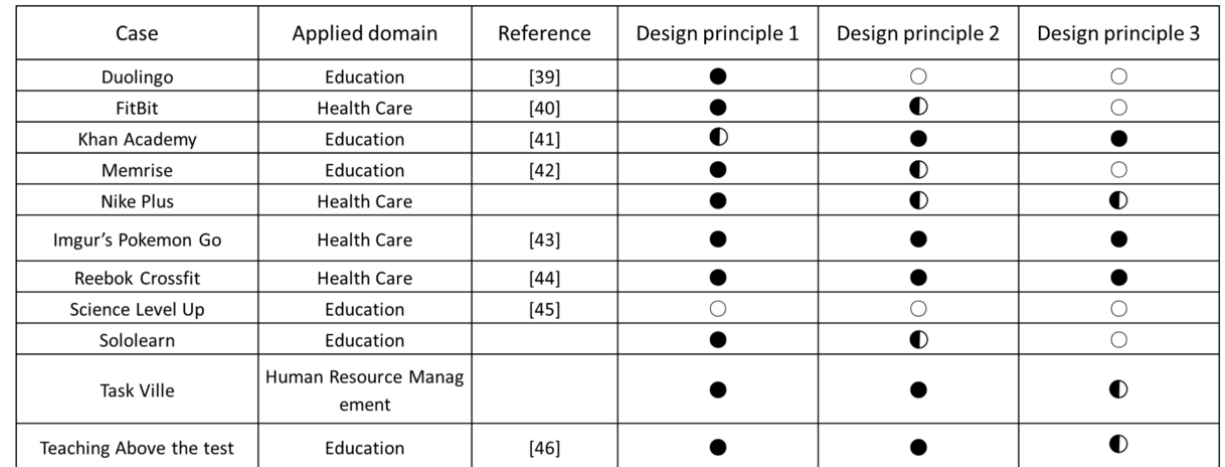
Figure 5. Collected leaderboard cases. ● : Completely applied; ◐ : partially applied; and ○ : not applied.